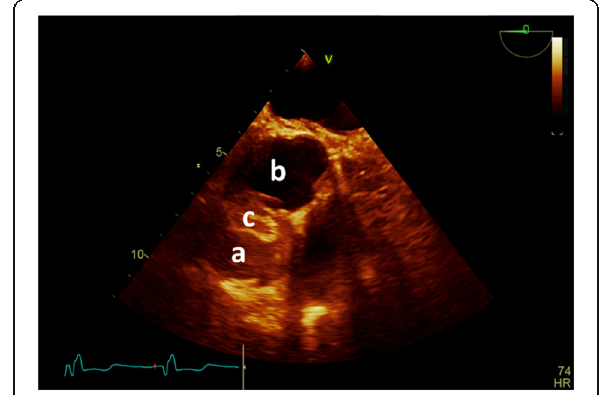
Fig. 6 Inra-opperative Trans-esophageal echocardiography. Completed and released device with good position and no residue. A pseudoaneurysm, ( B ) ascending aorta, ( C ) ASD device